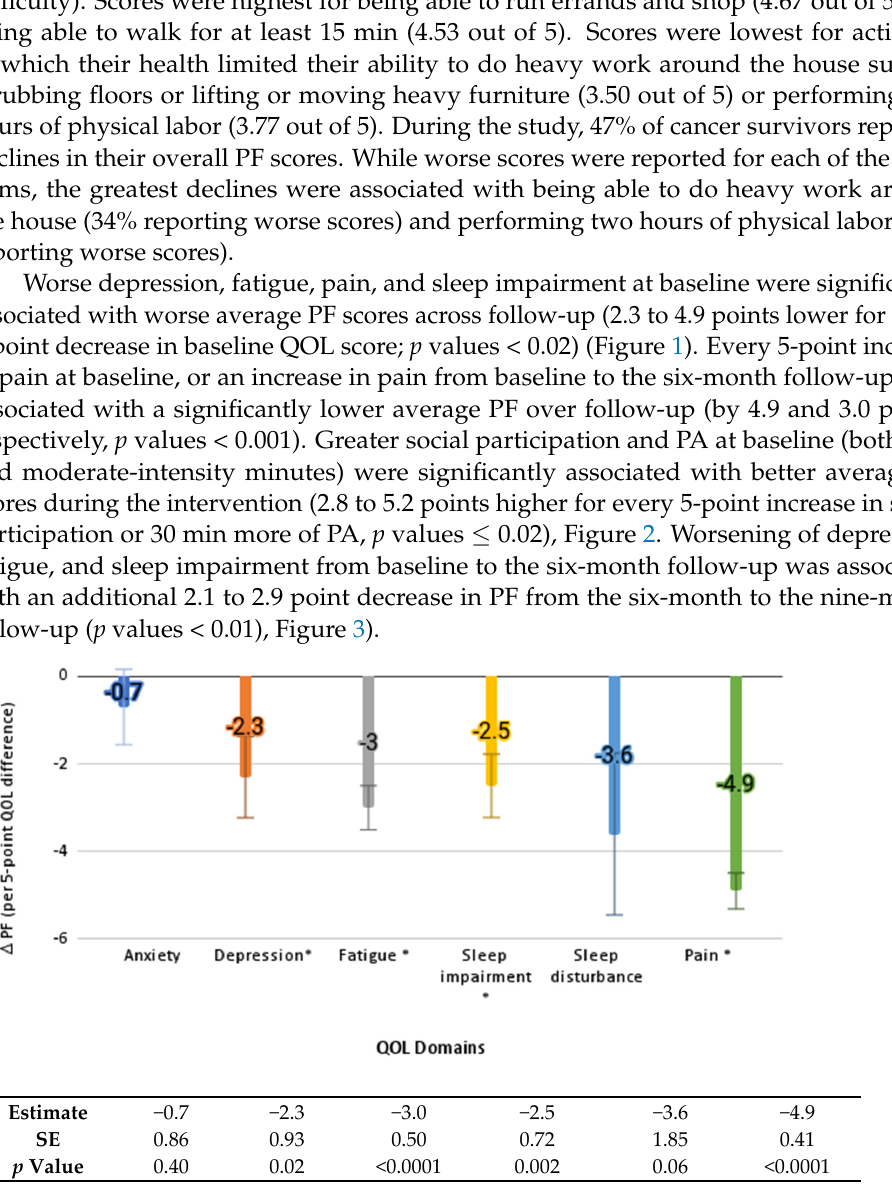
Figure 1. Change in physical function from baseline associated with baseline QOL domains. Error bars indicate standard error; * indicates statistical significance ( p < 0.05). PF: physical function; QOL: quality of life; SE: standard error.